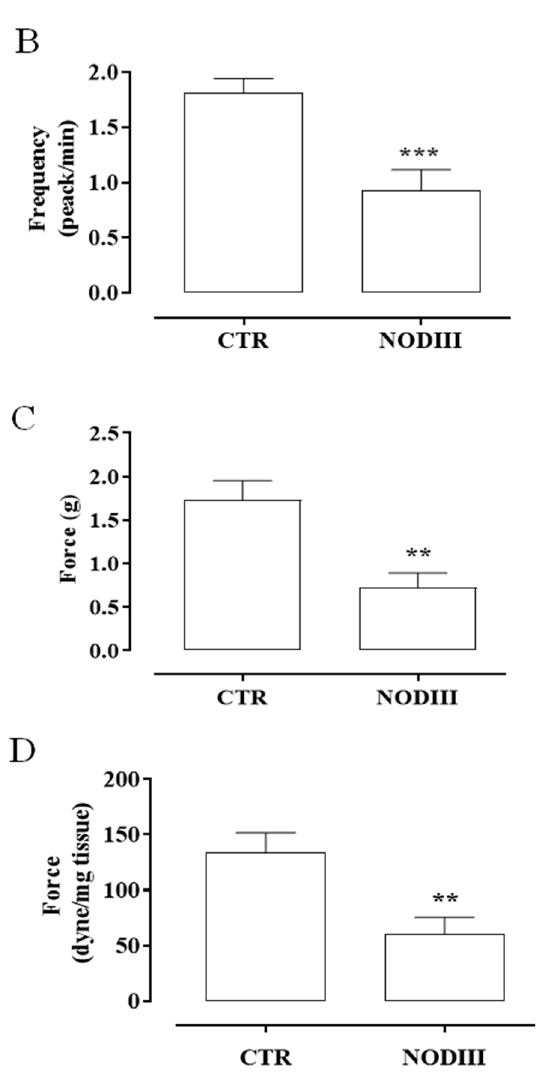
Figure 2. Spontaneous contractility in NODIII mice. A typical tracer of the basal contractility signal recorded by uteri harvested from CTR or NODIII mice ( A ). The basal response of uteri harvested from NODIII mice is significantly reduced compared to CTR mice. Data are reported as frequency, i.e., peak / min ( B ) (*** p < 0.001); contraction force, expressed in grams (panel C ; ** p < 0.01); or as dyne / mg tissue ( D ) (** p < 0.01). Results are calculated as mean ± SEM ( n = 12 mice) and analyzed by unpaired Student’s t-test.